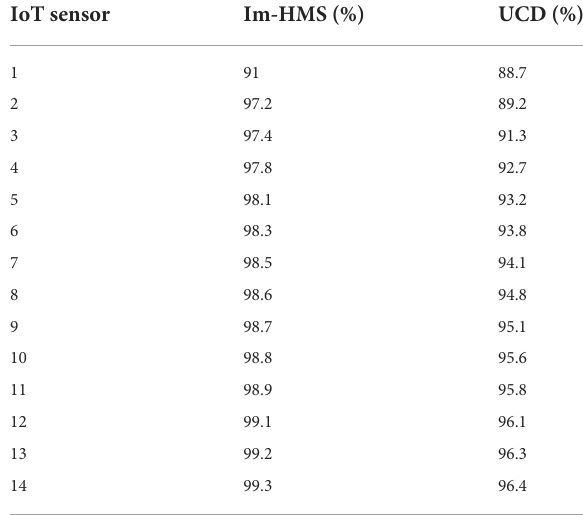
TABLE 2 Latency analysis of the proposed intelligent mobile health monitoring system (Im-HMS). Transmission range (%)